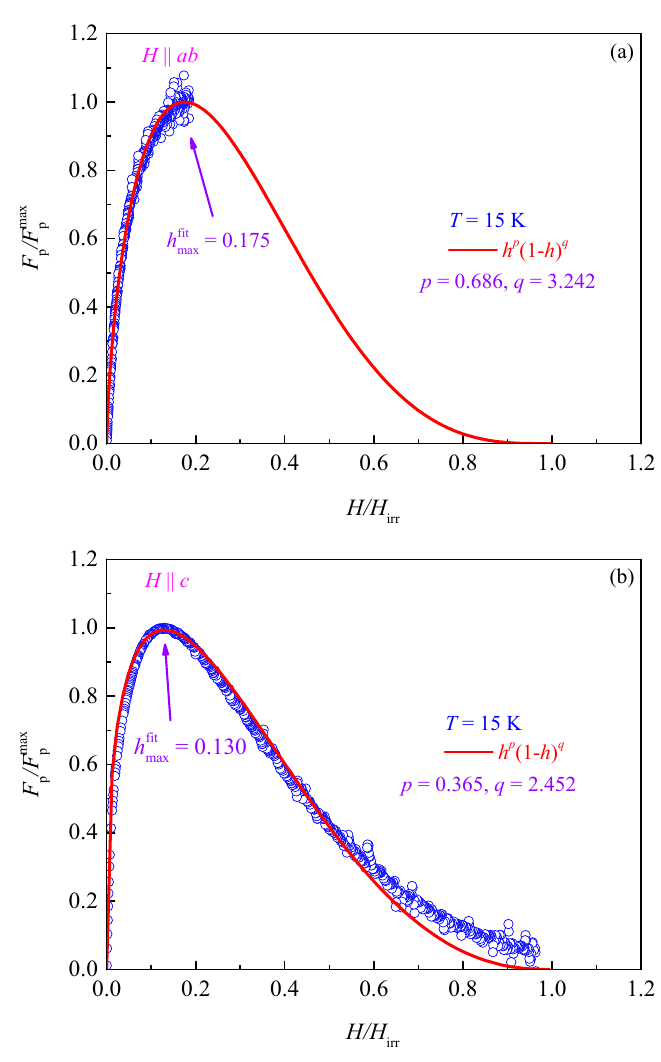
Figure 18. F p / F max p as a function of h = H / H irr for ( a ) H || ab and ( b ) H || c . The solid curves are fits of the data to the formula F p / F max p ∝ h p (1 − h ) q